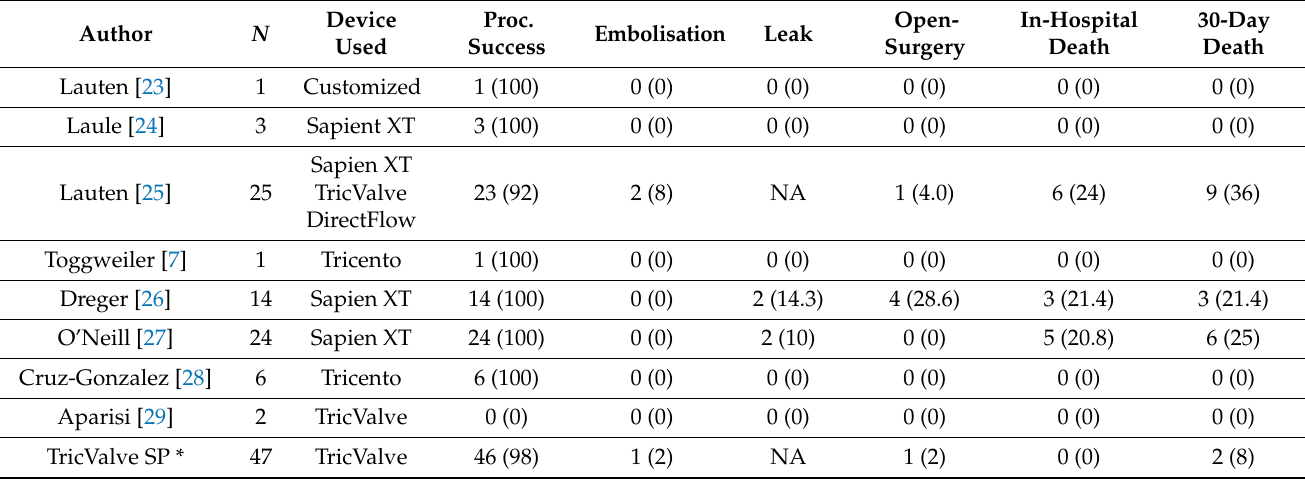
Table 2. Compassionate use CAVI data.